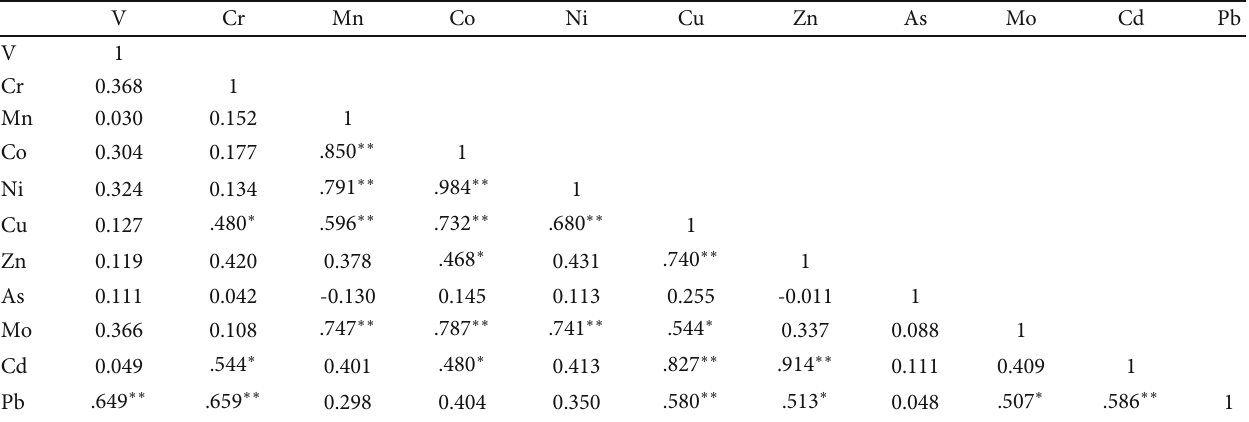
Table 5: Results of the Pearson ’ s correlation analysis of heavy metals.